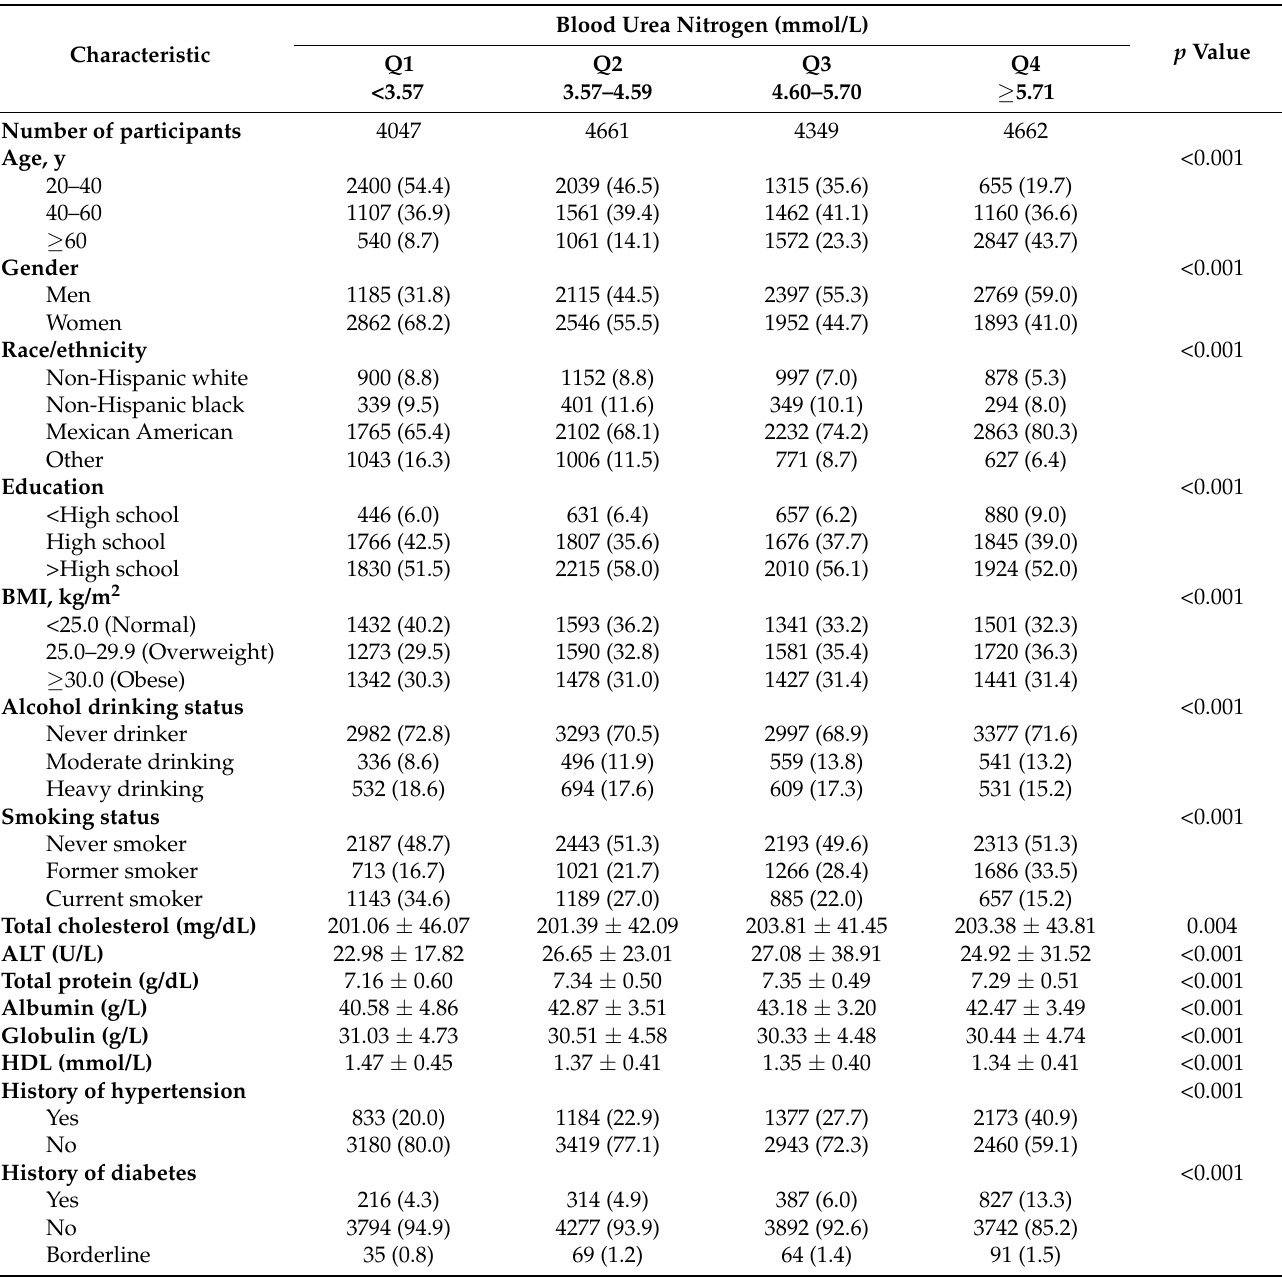
Table 1. Baseline demographic characteristics of the study population, according to quartiles of